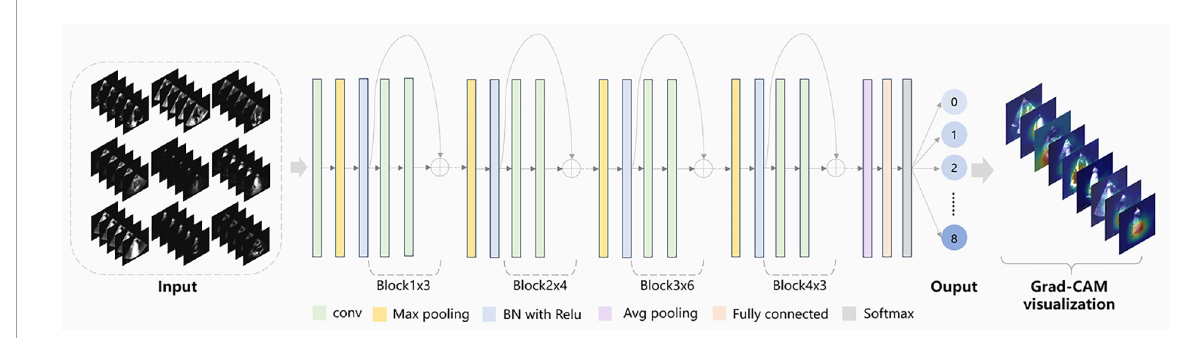
FIGURE1 Schematic diagram of echocardiographic view